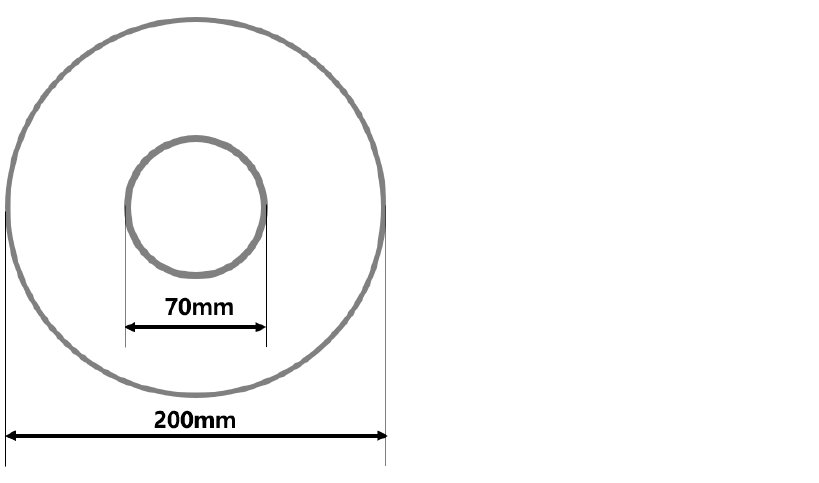
Figure 23. Comparison of strains between calculated prediction and simulation result.